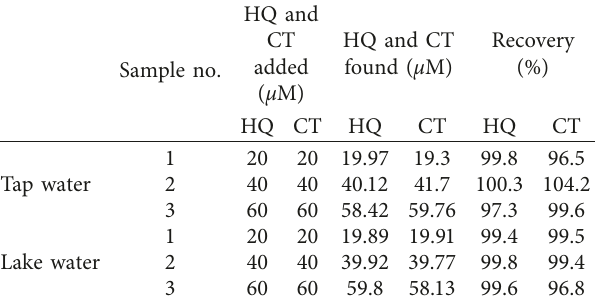
Table 3: Estimation of HQ and CTin local tap water and lake water samples.